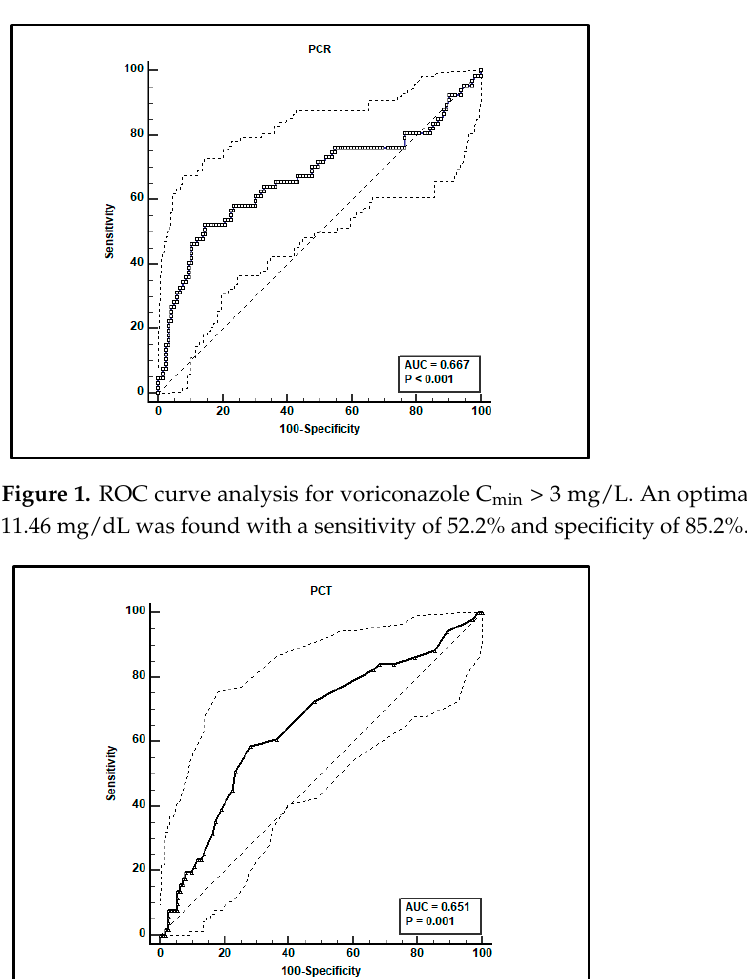
Figure 2. ROC curve analysis for voriconazole C min > 3 mg/L. An optimal cut-off of PCT value > 0.3 ng/mL was found with a sensitivity of 58.8% and specificity of 71.8%.